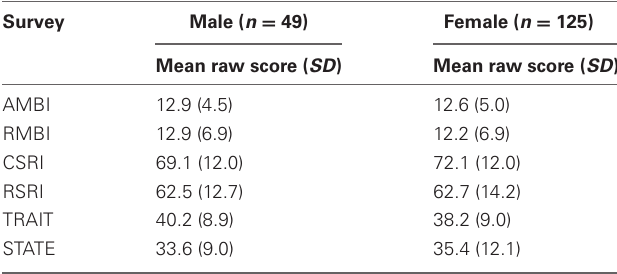
Table 1 | Descriptive summary of scores on self-report scales.